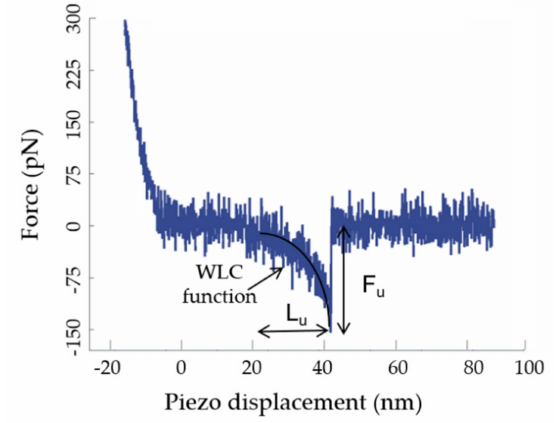
Figure 4. Representative experimental retraction force curve showing a specific unbinding event corresponding to the rupture of a single AnFNR ox :NADP + complex. Starting from the zero-force